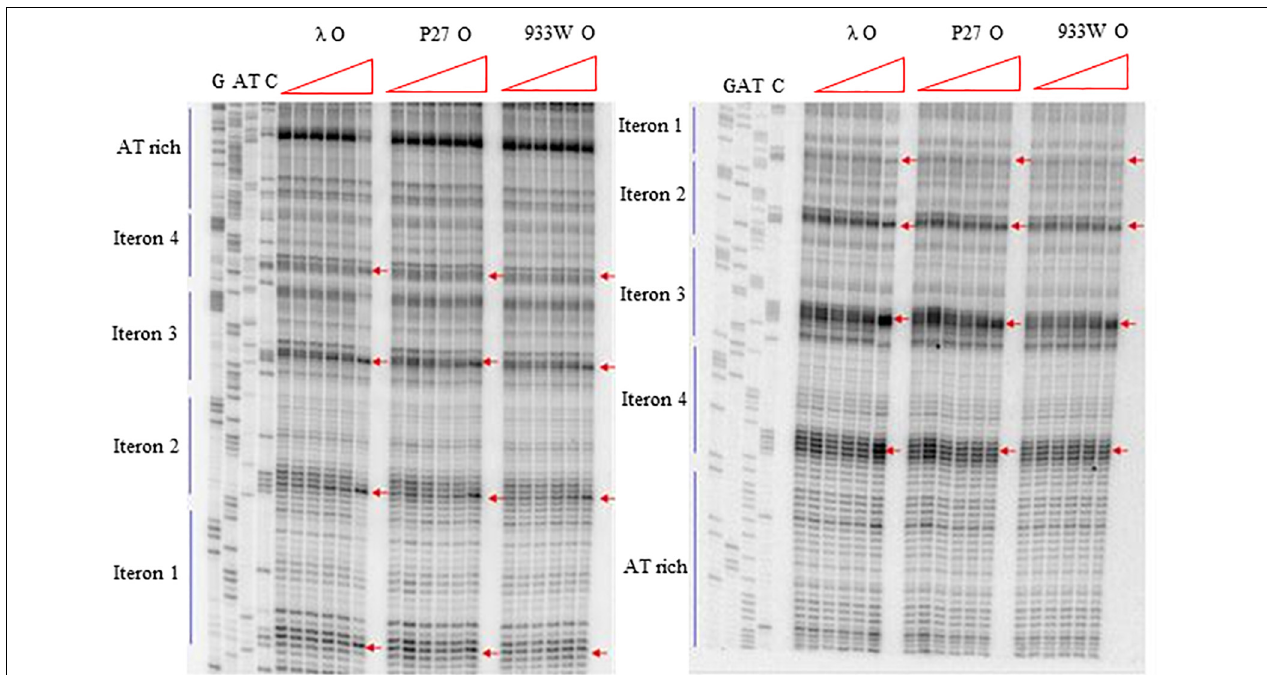
FIGURE 4 | Interactions of O proteins of phages λ , P27 and 933W with DNA templates containing four iterons, as assessed by DMS footprinting. Increasing molar ratios of DNA:O proteins, indicated in particular wells, were as follows: 1:0 (no O protein), 1:2, 1:4, 1:8, 1:16, and 1:32. Arrows indicate major changes (enhancement) in bands’ intensities.